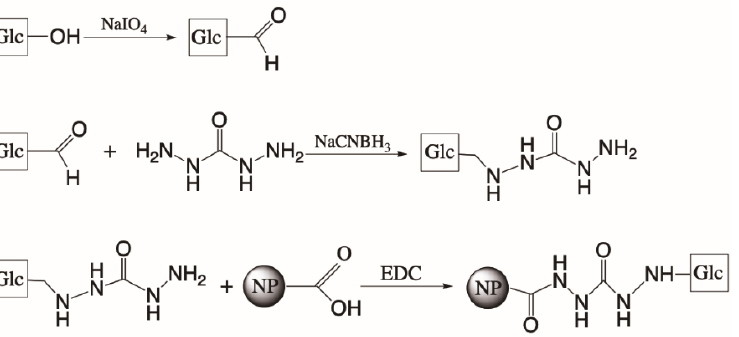
Figure 1. Schematic representation of the chemical conjugation of soluble WGP onto COOH-PS NP surface.